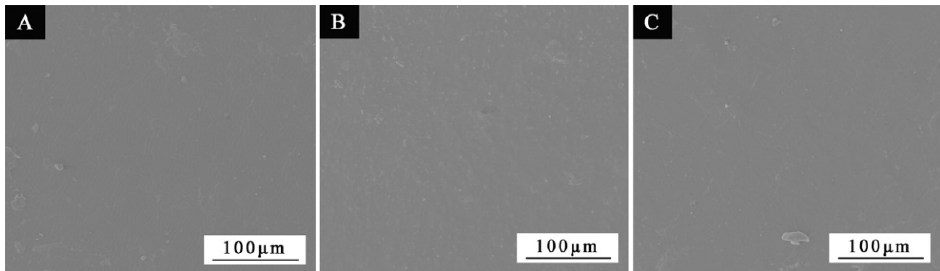
Figure 2. Morphology of the film prepared with different finishing processes: ( A ) photochromic primer + thermochromic topcoat; ( B ) thermochromic primer + photochromic topcoat; ( C ) photo- chromic and thermochromic coating.